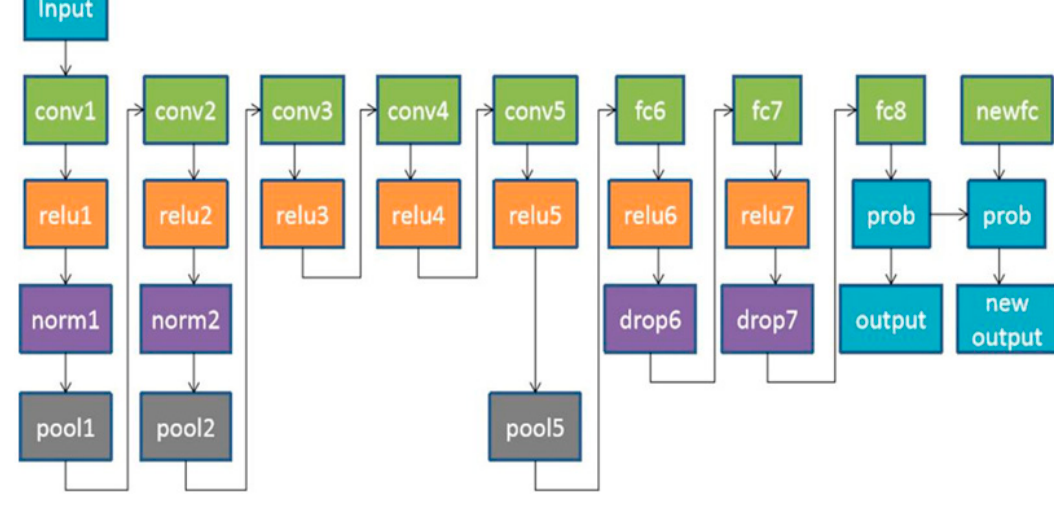
Figure 3. The architecture of AlexNet with dropout.